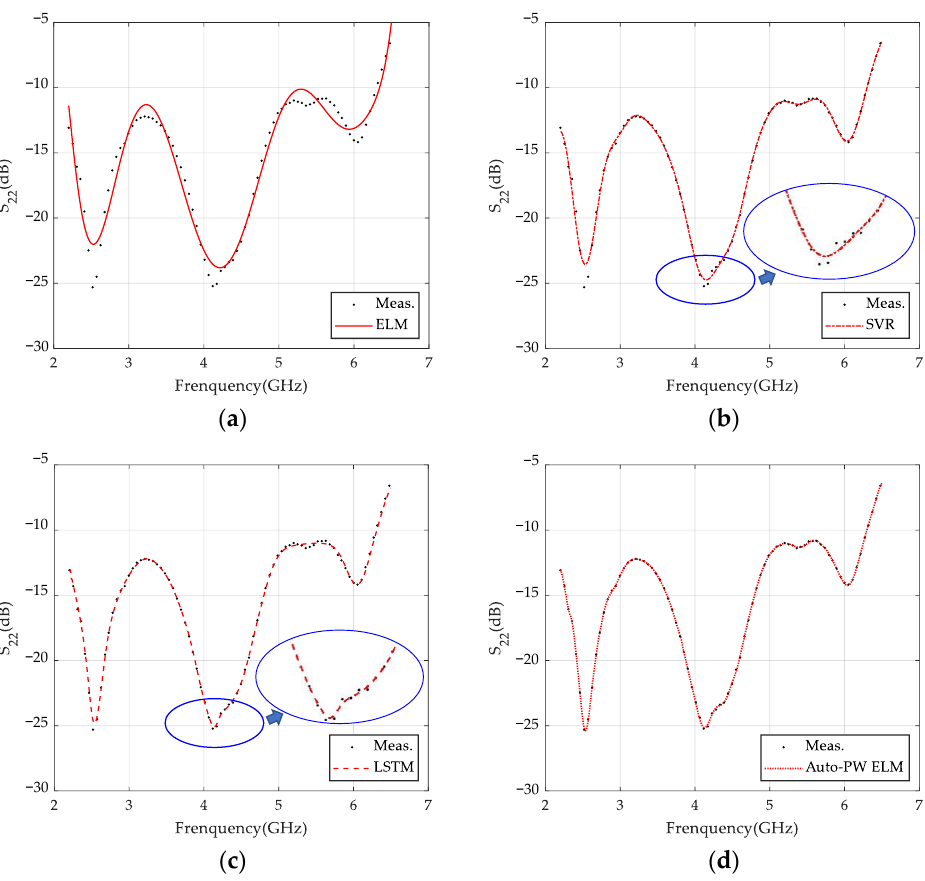
Figure 9. Modeling results of S 22 parameters. ( a ) Comparison of ELM model and measured data. ( b ) Comparison of SVR model and estimated data. ( c ) Comparison of LSTM model and measured data. ( d ) Comparison of automatic piecewise ELM model and measured data.